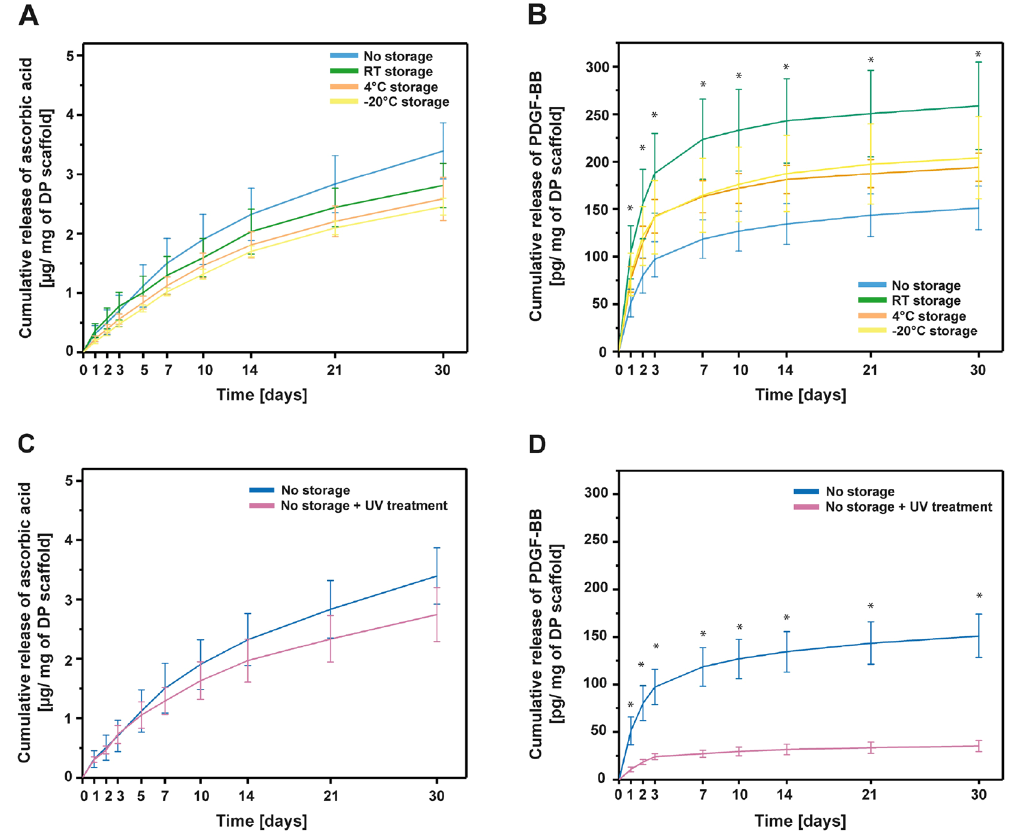
Figure 3. PDGF-BB and ascorbic acid release from differently stored and UV sterilized bioactive DP scaffolds. ( A , B ) In vitro cumulative release of ascorbic acid and PDGF-BB from differently stored (not stored, room temperature/ + 4 °C/ − 20 °C stored) emulsion electrospun DP scaffolds, respectively. ( C , D ) In vitro cumulative release of ascorbic acid and PDGF-BB from non-sterilized or UV sterilized emulsion electrospun DP scaffolds, respectively. * p <